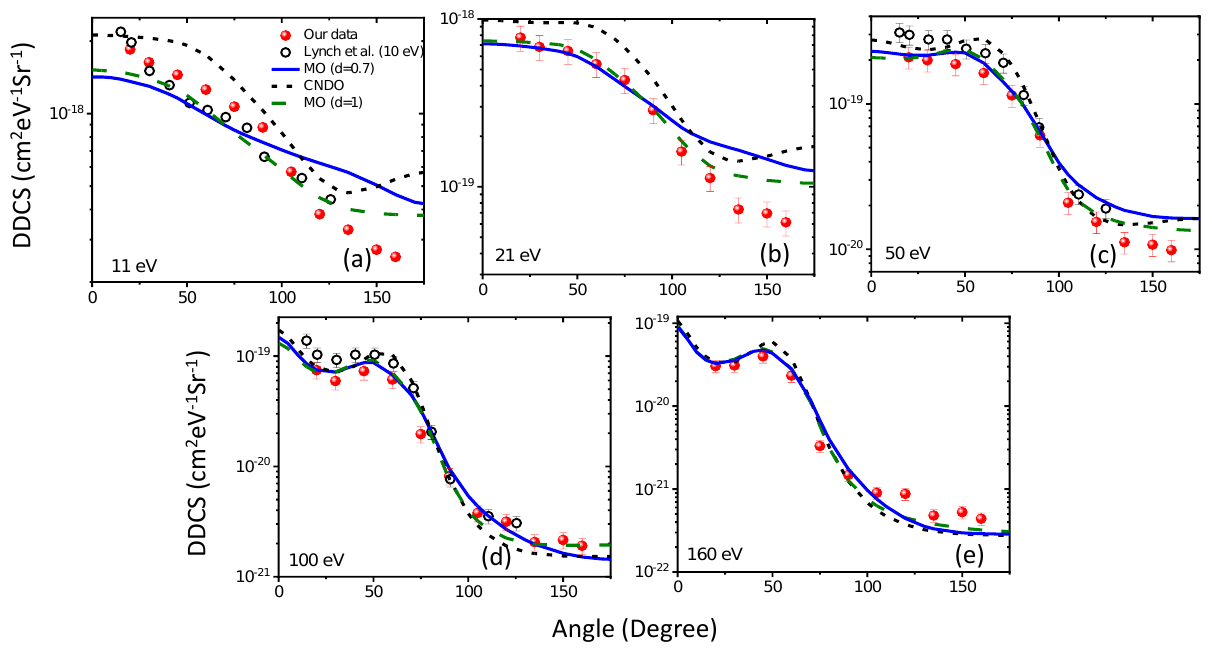
Figure 2. Angular distributions of the present DDCS (red circles) along with the models and the data available in the literature (black open circles) [8]. The solid, dashed and dotted lines are CDW − EIS (MO) ( d = 1), CDW − EIS (MO) ( d = 0.7) and CDW − EIS (CNDO),